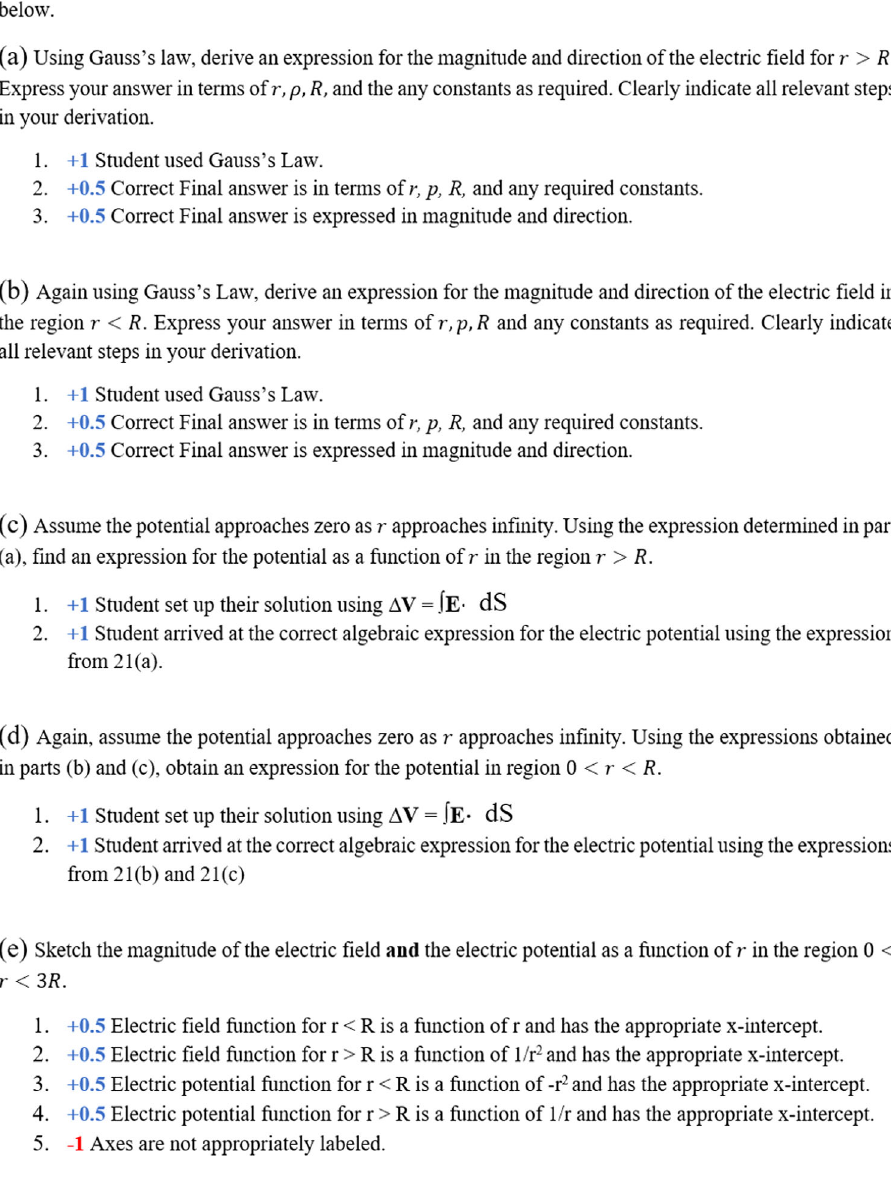
FIG. 1. Rubric for free response question